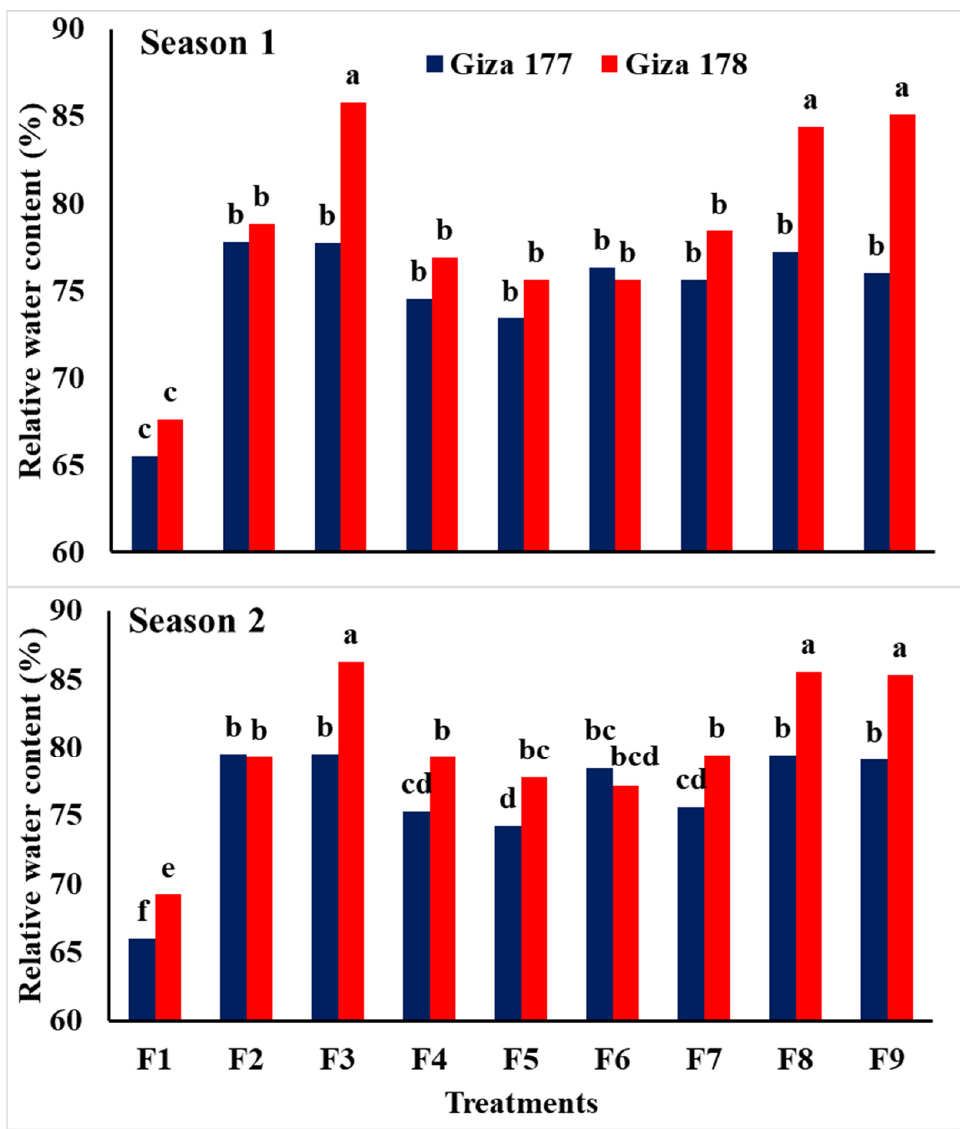
Figure 2. Interaction effect of NPs-Si and NPs-Se treatments on relative water content (%) of the two rice varieties under saline soil conditions during the first and second seasons. F1 = control; F2 = soaking-NPs-Si; F3 = soaking-NPs-Se; F4 = foliar-NPs-Si at MT; F5 = foliar-NPs-Se at MT; F6 = foliar-NPs-Si at PI; F7 = foliar-NPs-Se at PI; F8 = foliar-NPs-Si at BT; F9 = foliar-NPs-Se at BT; NPs-Si = nanoparticles of silicon; NPs-Se = nanoparticles of selenium, MT = mid tillering stage; PI = panicle initiation; BT = mid booting stage. Means followed by the same letter were not significantly different for probability ( p ) ≤ 0.05.